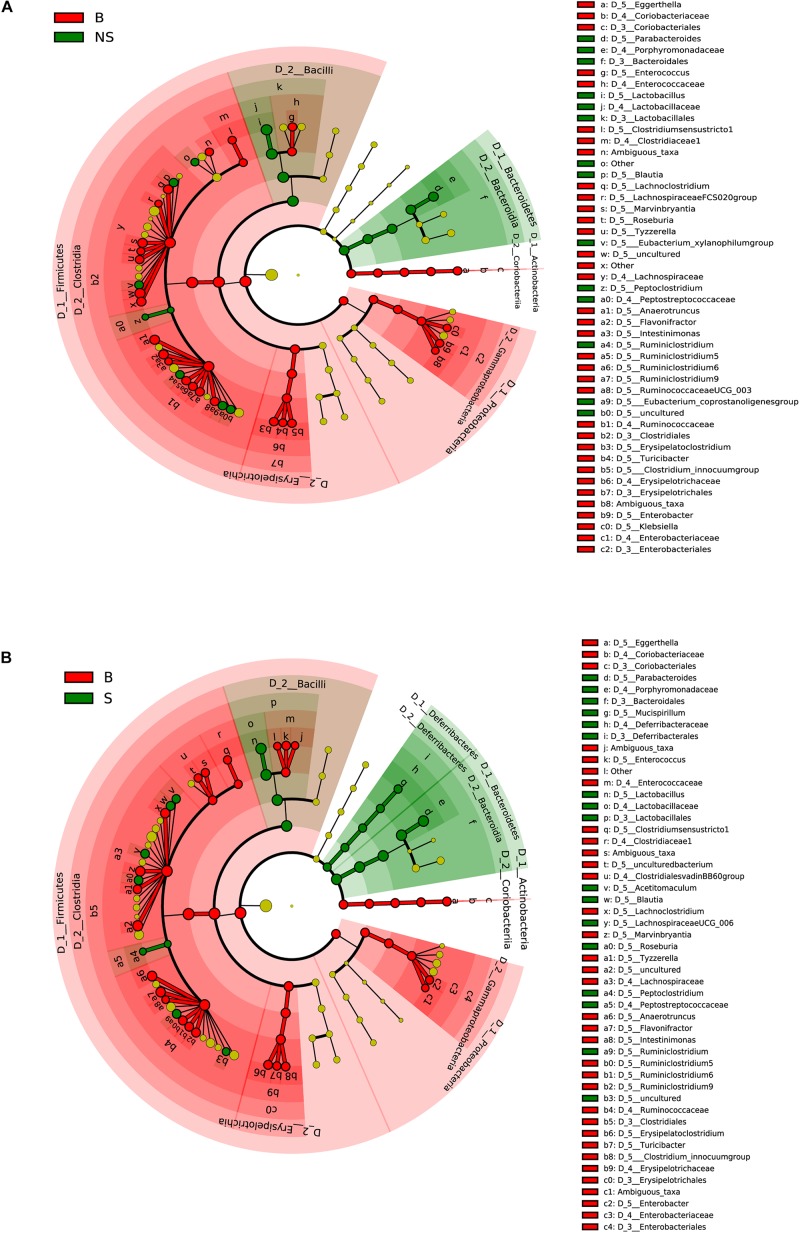
Different structures of the microbiota in BALB/cA and NOD/SCID mice or BALB/cA and SCID mice. (A) Taxonomic representation of statistically and biologically consistent differences between BALB/cA and NOD/SCID mice. Differences are represented by the color of the most abundant class (red indicates BALB/cA mice, and green indicates NOD/SCID mice). (B) Taxonomic representation of statistically and biologically consistent differences between BALB/cA and SCID mice. Differences are represented by the color of the most abundant class (red indicates BALB/cA mice, and green indicates SCID mice). The diameter of each circle is proportional to the taxon’s abundance.